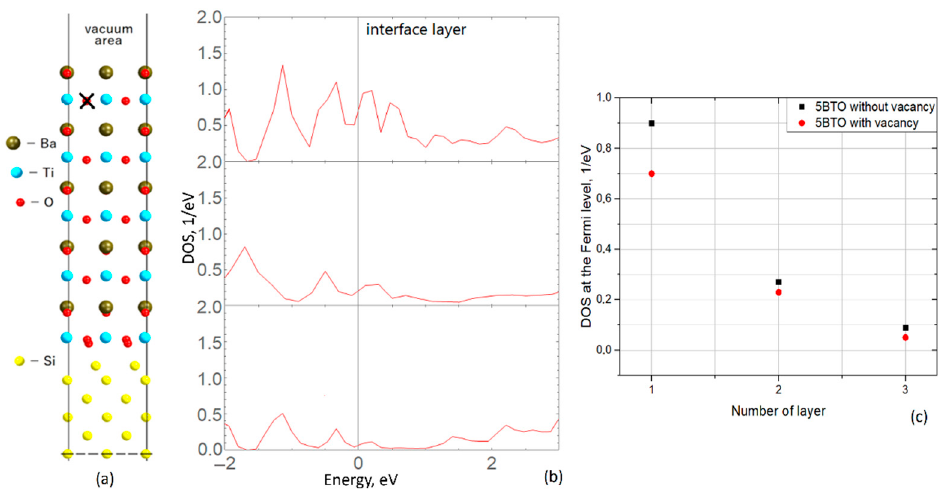
Figure 4. ( a ) The creation of an oxygen vacancy is demonstrated; the structure is identical to that shown in Figure 2. ( b ) Layer-resolved DOS spectra for a silicon substrate of a heterostructure with an oxygen vacancy located at the surface. The upper spectrum is associated with the interface layer; that is, the layer at the silicon-BTO interface, and the bottom one corresponds to the central layer of the modeled substrate. ( c ) The plot of the dependence of DOS values at the Fermi level on the number of layers, where “1” is the interface. A decay towards the center of the substrate is observed here. Lastly, the spin polarized calculations were performed to test the magnetic properties of the BTO/Si heterostructure. In Figure 5, the spin-polarized atom-resolved DOS spectra for the bare 5BTO/Si heterostructure (a) and with oxygen vacancy (b) are presented. The heterostructures used to obtain plots are the same as used above (Figures 2a and 4a, re- spectively). The spin-polarized calculations revealed that the systems are slightly mag- netic; in particular, the system without vacancy is negligibly magnetized, whereas the sys- tem with surface vacancy has magnetic moments per surface Ti atoms of 0.183 μ B . Thus, the presence of oxygen vacancy does not have a substantial influence on the electronic and magnetic properties. Qualitatively and quantitatively, the behavior does not change significantly. Let us now consider a heterostructure LaMnO 3 /BaTiO 3 (LMO/BTO) in which, even without the presence of oxygen vacancies, a significant magnetic order can exist at the interface. Figure 5. ( a ) Spin-polarized DOS spectra for bare BTO/Si and with ( b ) oxygen vacancy. ( c ) Top view on the surface TiO 2 layer of the BTO/Si heterostructure with O-vacancy with denoted magnetic mo- ments per atom in μ B .